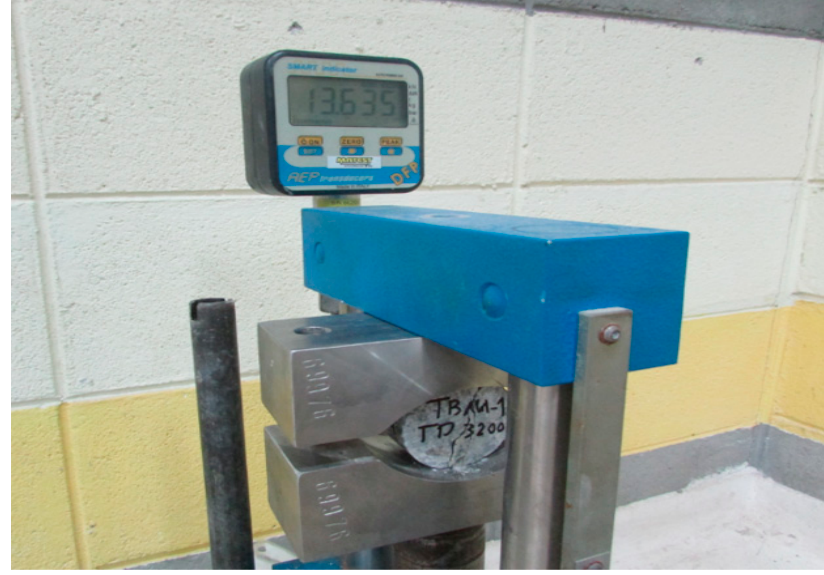
Figure 2. Failure of a sample collected from the tunnel project (tunnel boring machine (TBM) 1, tunnel distance = 3200 m) under Brazilian test.